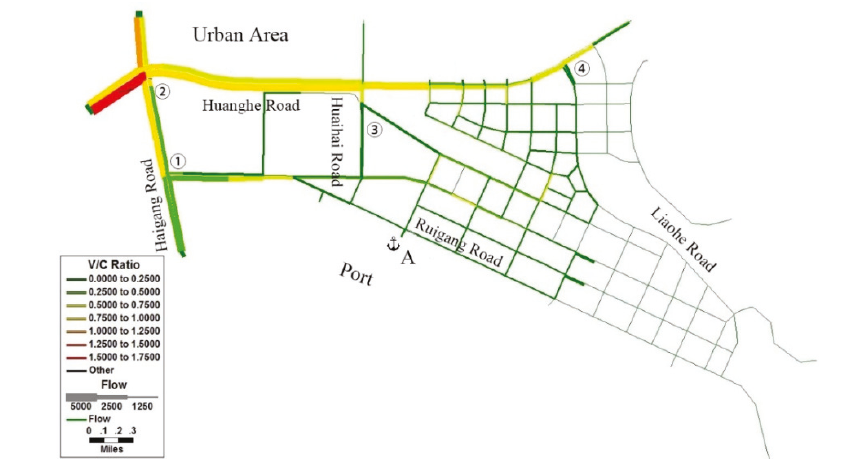
Figure 18: The traffic volume of PCDN in 2020 without interchange.